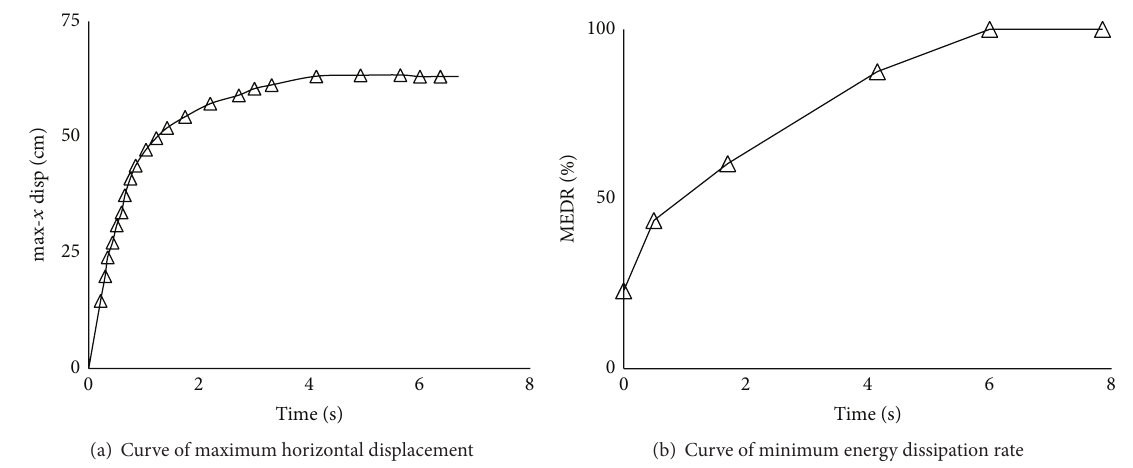
Figure 4: Results when strength reduction factor is 1.35.